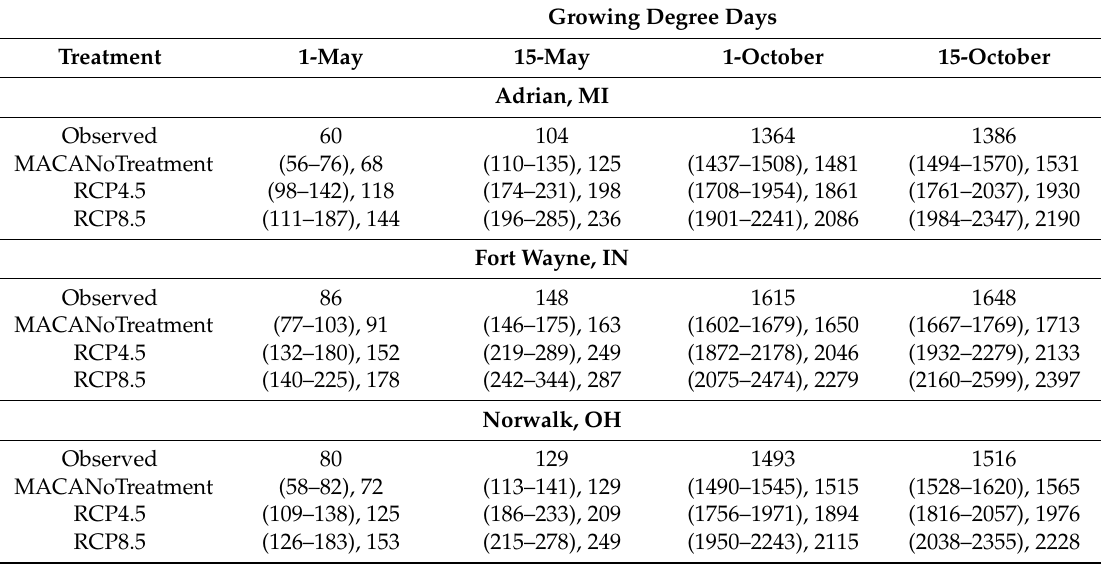
Table 8. Comparison of Growing Degree Days (GDD) under future climate scenarios (2006–2099) with those from the historical period (1966–2005) at Adrian, MI, Fort Wayne, In, and Norwalk,